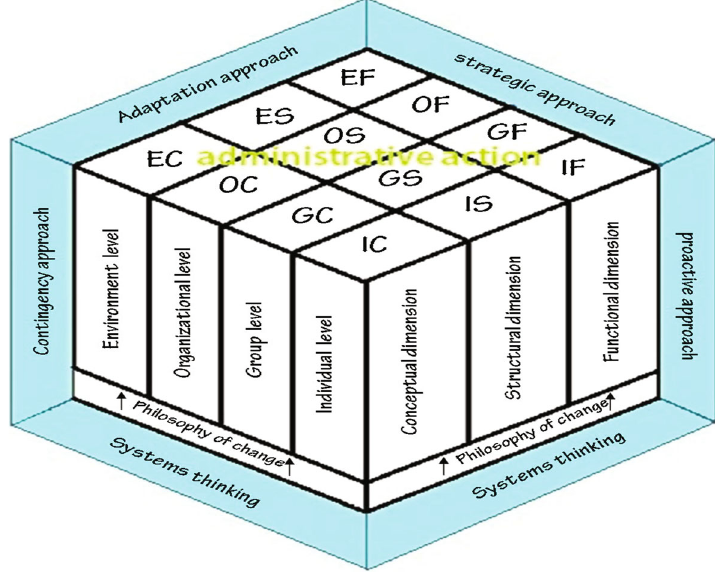
Figure 2: The matrix of the relationship between organizing